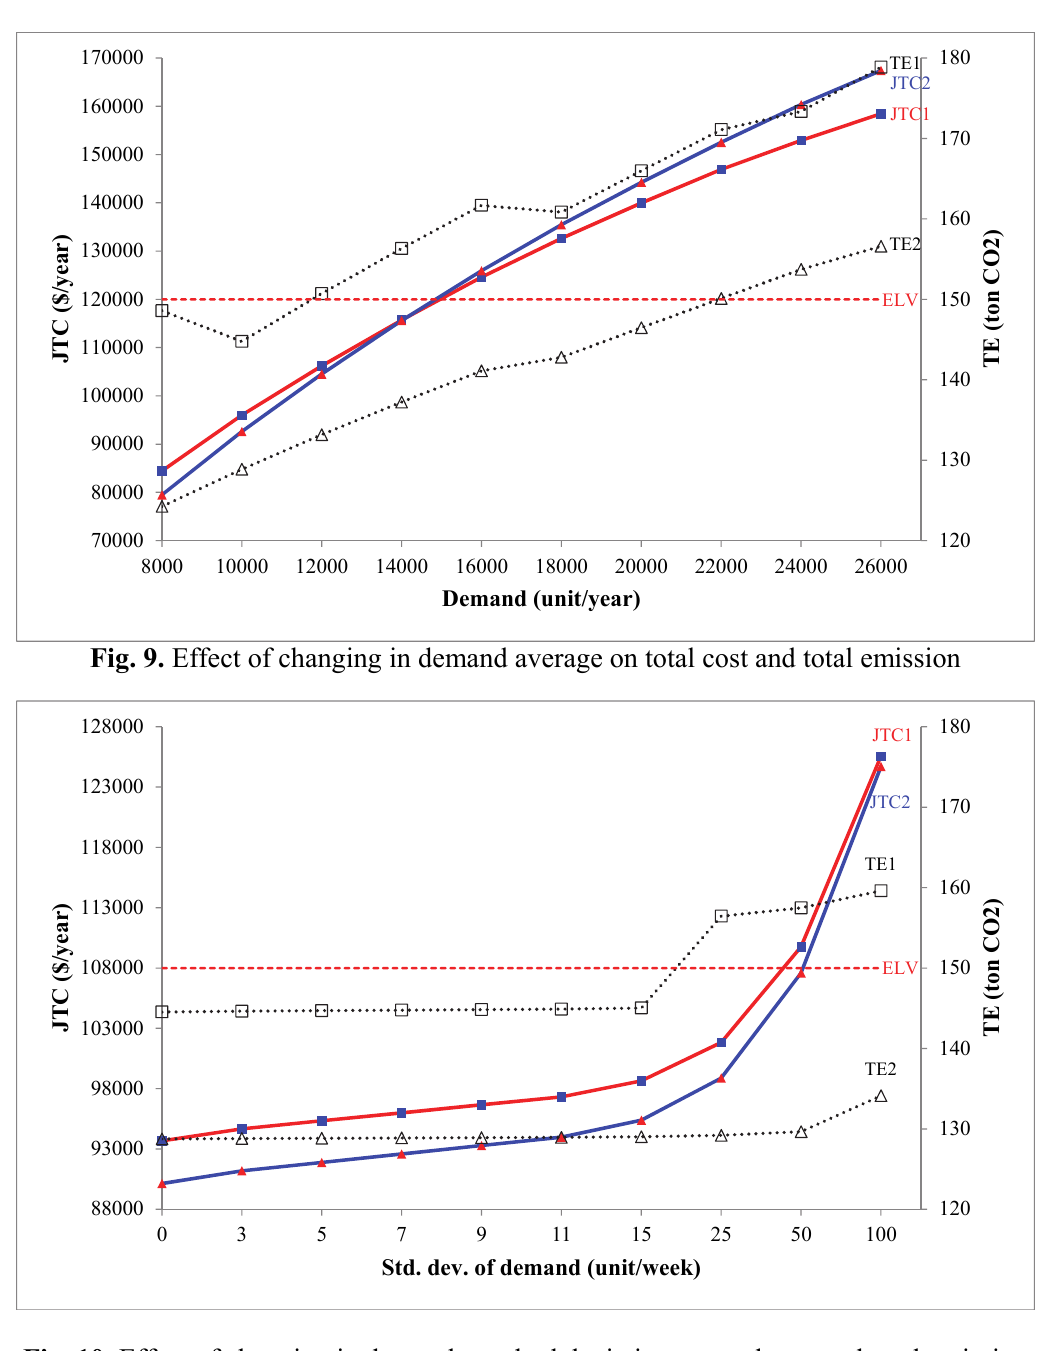
Fig. 10. Effect of changing in demand standard deviation on total cost and total